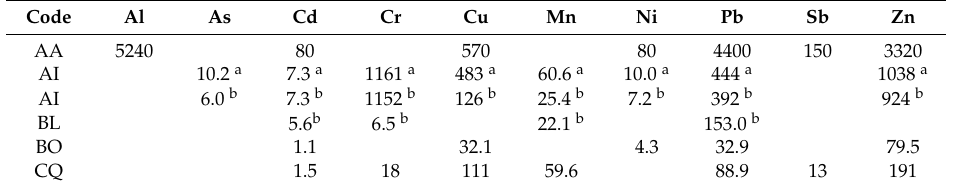
Table 5. Concentration of heavy metals and metalloids in air samples (values expressed in ng / m 3 ). Code